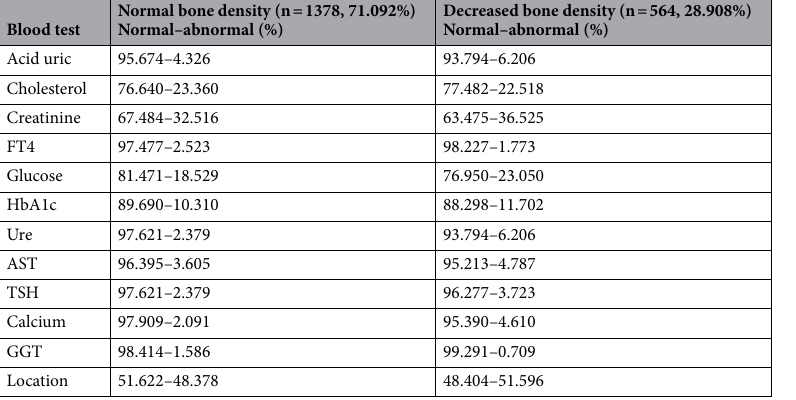
Normal bone density (n = 1378, 71.092%) Blood test Normal–abnormal